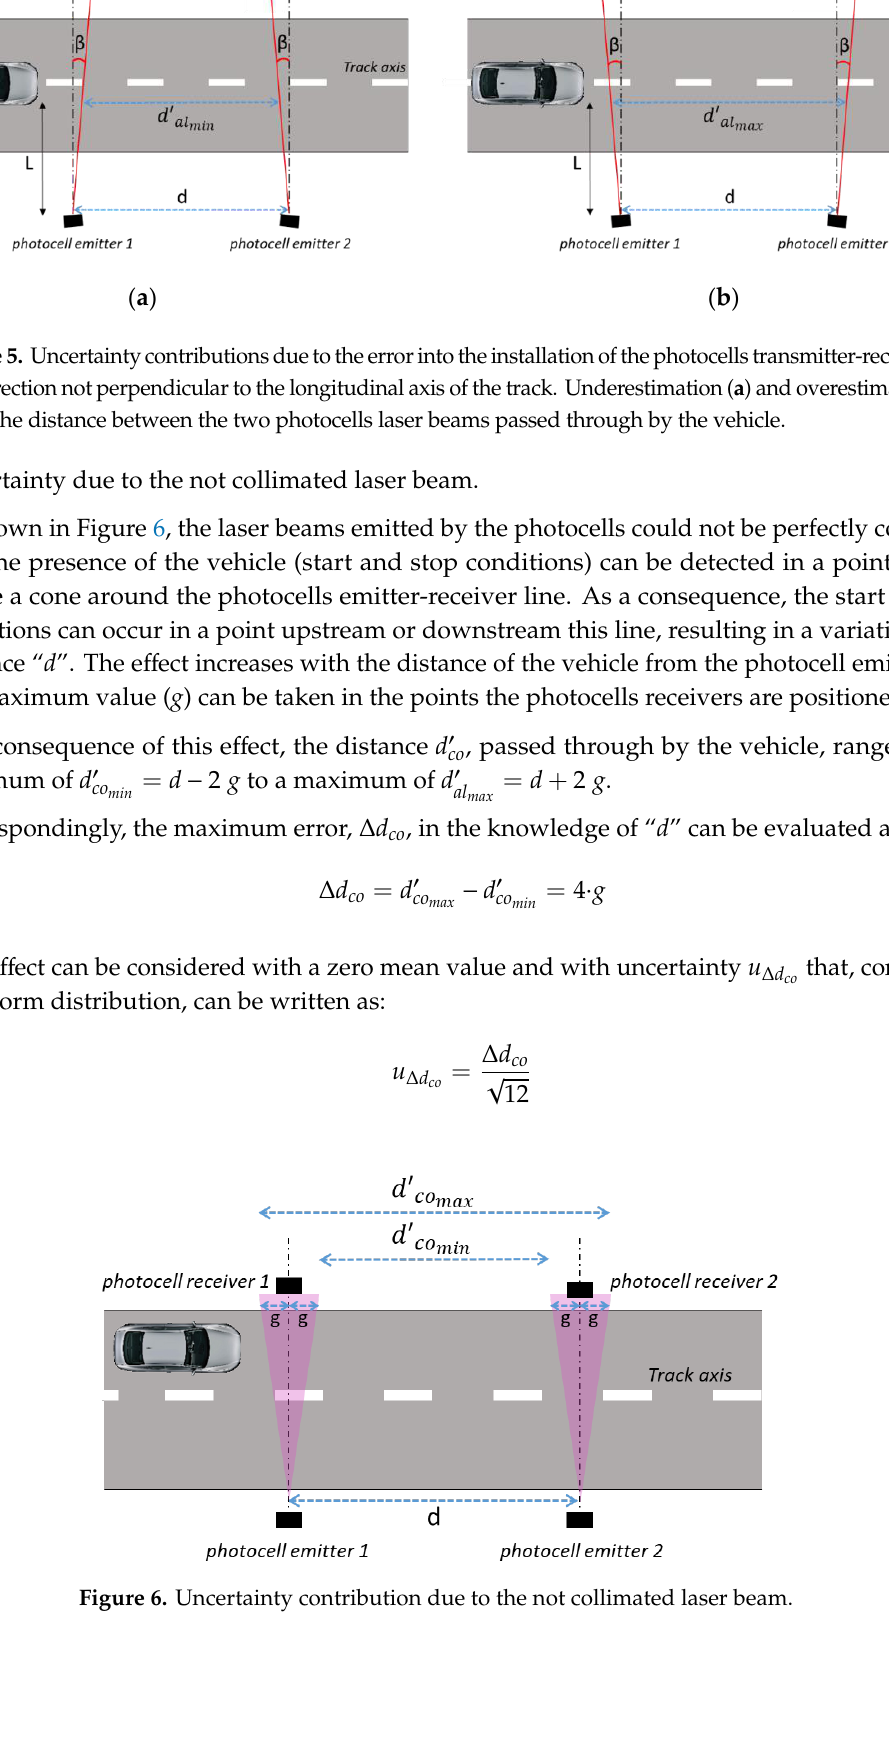
7 of 21 Figure 4. Uncertainty contribution due to the vehicle trajectory along the track: short distances ( a ) and long distances ( b ). The amplitude of this effect is strictly connected to the skills of the driver, the value of the distance d, and the speed of the test vehicle. Fixing the driver skills, the greater the distance d and the lower the speed value, the greater ∆𝑑 𝑐𝑡 can be. For instance, in Figure 4b, a case in which for longer distance d the driver correcting the trajectory around the track axis can have an amplification of the effect on ∆𝑑 𝑐𝑡 is shown. This effect can be considered with a zero mean value and with an uncertainty 𝑢 ∆𝑑 𝑐𝑡 that, considering a uniform distribution, can be written as: 𝑢 ∆𝑑 𝑐𝑡 = ∆𝑑 𝑐𝑡 √12 (12) • Uncertainty due to the error into the installation of the photocells transmitter-receiver in a direction not perpendicular to the longitudinal axis of the track. As is drawn in Figure 5, the laser beams emitted by the photocells can form an angle ( β ) respect to the direction orthogonal to the track axis. This can be caused by the not ideal methodology used to install of the photocells couples on the track. As a consequence of this effect, the distance 𝑑 𝑎𝑙′ , passed through by the vehicle, ranges from a minimum of 𝑑 𝑎𝑙 𝑚𝑖𝑛 ′